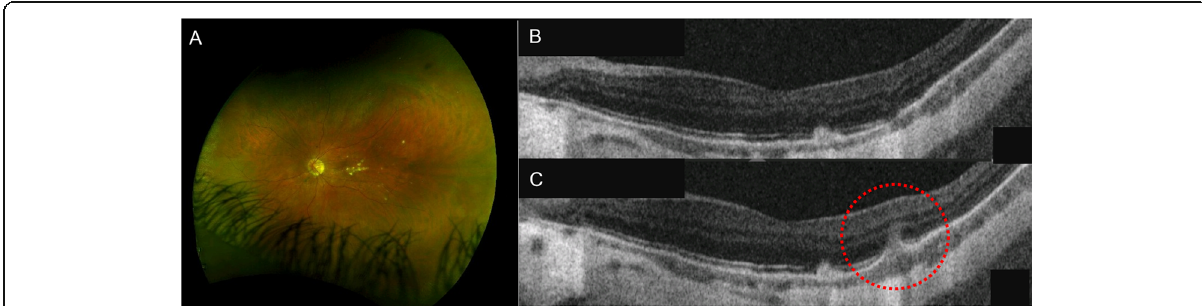
Fig. 4 Punctate Inner Choroidopathy. A Left eye ultra-wide field fluorescein angiography showing choriorerinal scars located at the posterior pole; B correlating with atrophy of the outer retina and retinal pigment epithelium (RPE) on optical coherence tomography (OCT). C OCT showing elevation of the RPE with underlying hyporeflective space between the RPE and Bruch ’ s membrane (circle) and increased penetration of light through the inner choroid, suggestive of disease recurrence